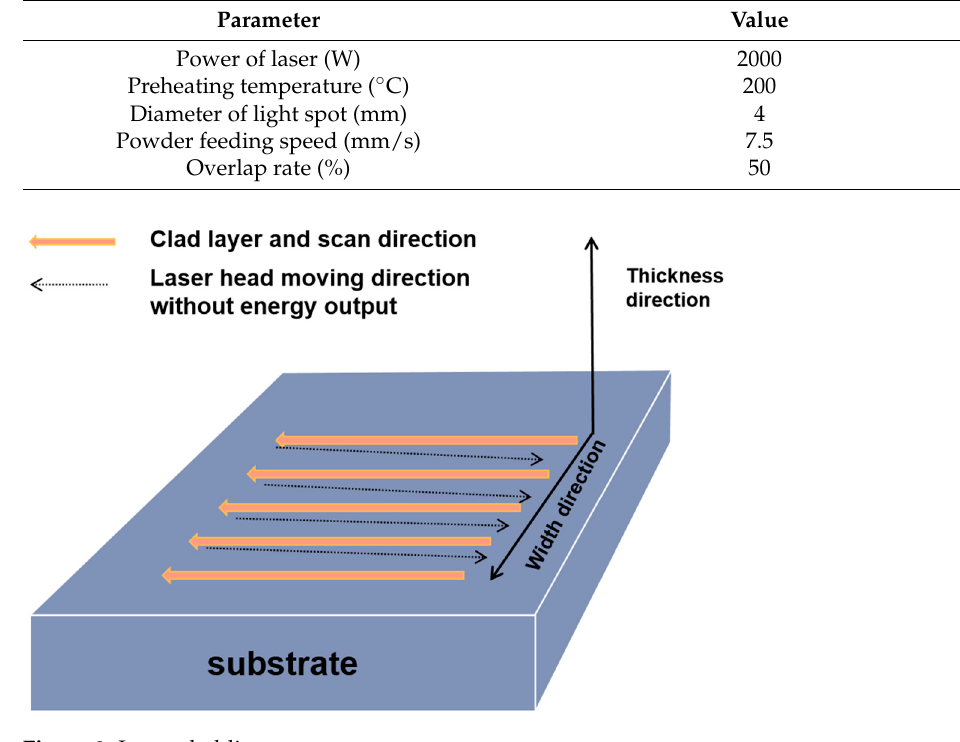
Figure 2. Laser-cladding process.